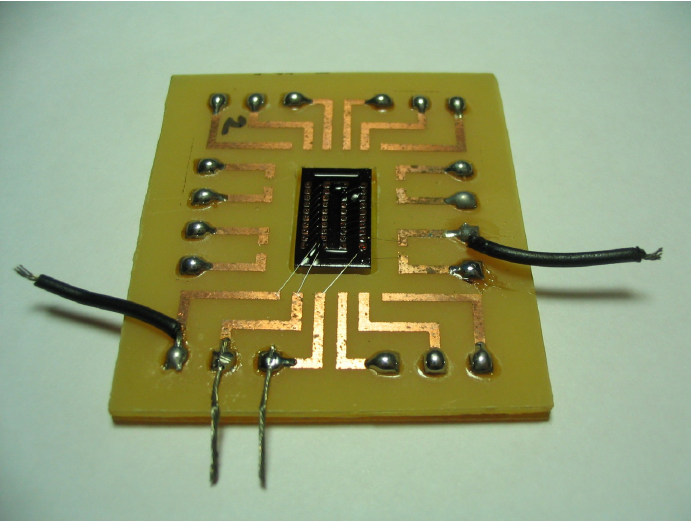
Figure 8. The measuring sample of MEMS